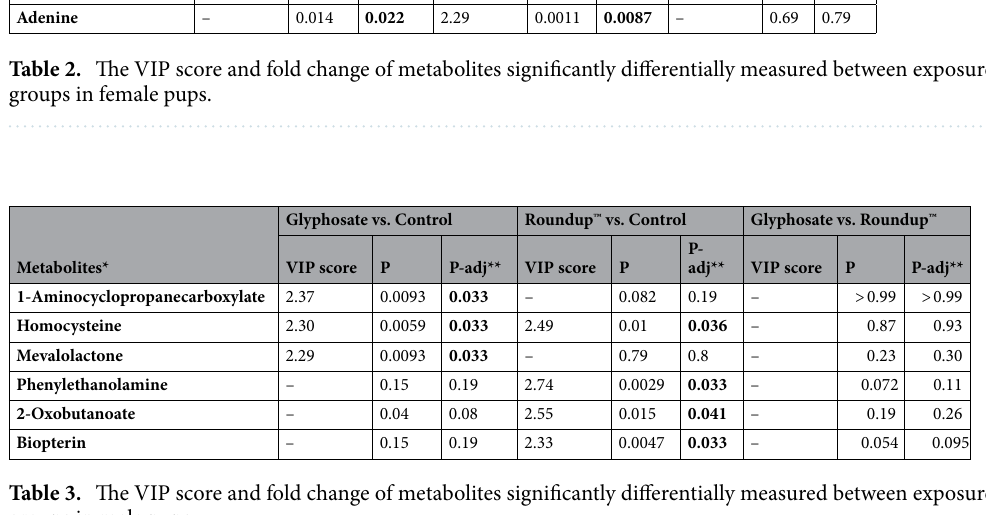
feature selection method with the Boruta algorithm. Among the metabolites selected by RF (Table S2, Fig. S5), we found many selected features were consistent with the results from the PLS-DA.